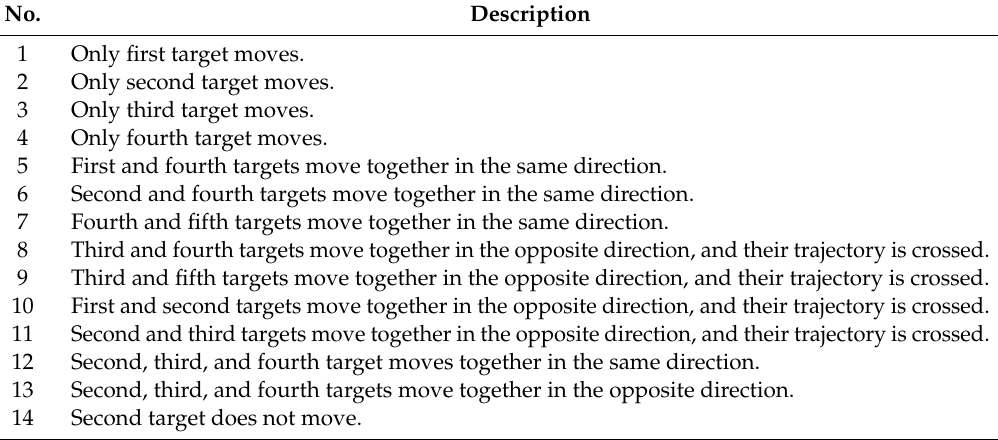
Figure 6. Classification error in tests. Table 5. Experiment